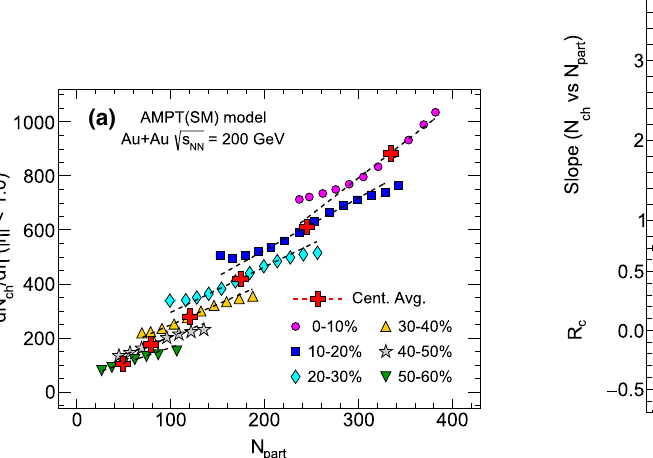
red dotted line showing the slope of the centrality averaged values and solid stars showing the average slope of the values in the n spec bin for each centrality; the bottom panel shows the relative difference between slopes ( R c